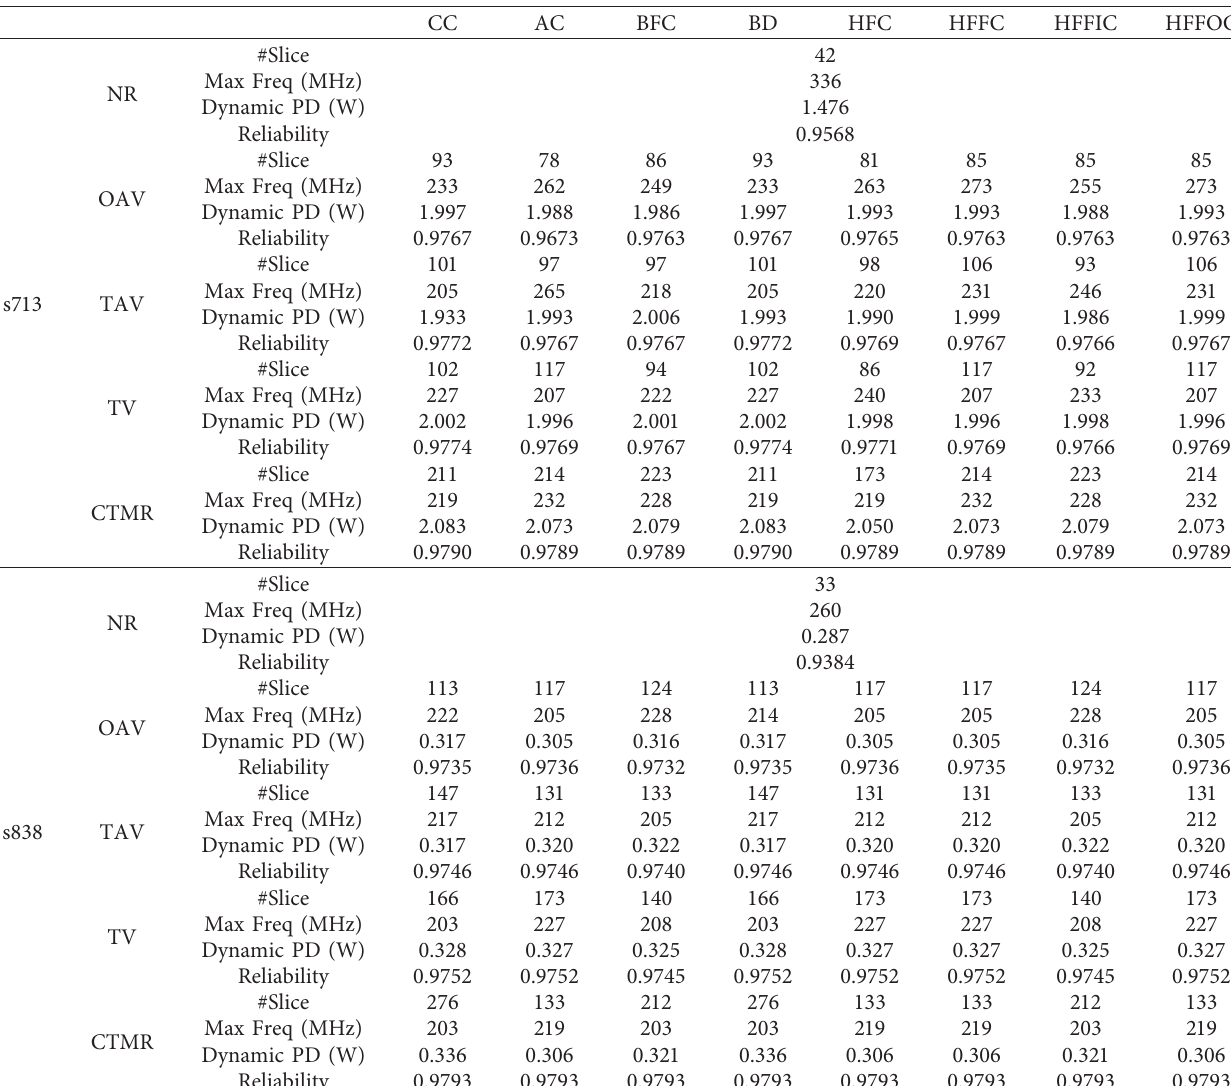
Table 2: Design space exploration results for the benchmarks s713 and s838 from the ISCAS’89 benchmark suite.